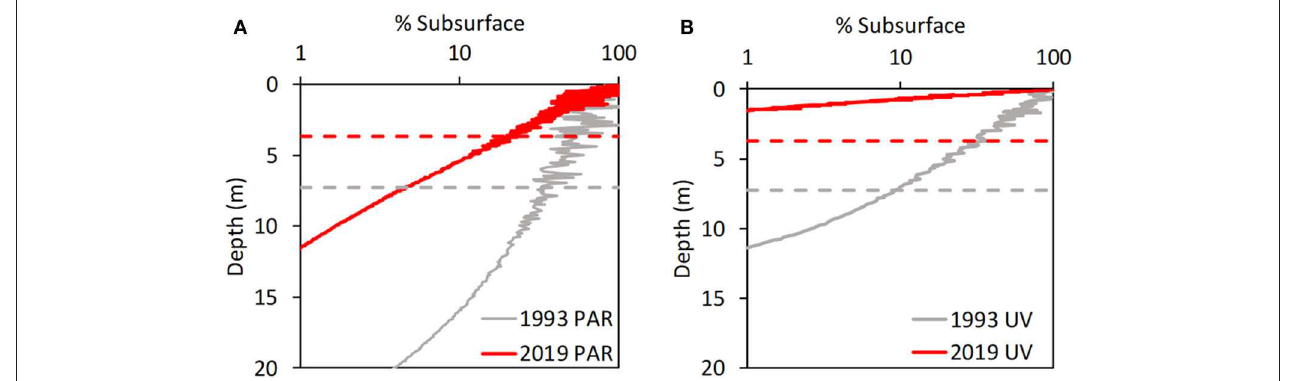
FIGURE 3 | Vertical profiles of PAR (A) and 320nm UVR (B) in Lake Giles relative to the depth of the mixed layer (dashed lines) in 1993 and 2019. Note the strong shallowing of the compensation depth (1% of subsurface) for PAR, which influences the balance of photosynthesis and respiration, and thus the depth of light limitation of photosynthesis as well as oxygen depletion in the deeper waters. There is also a strong reduction in UVR and PAR exposure levels in the mixed